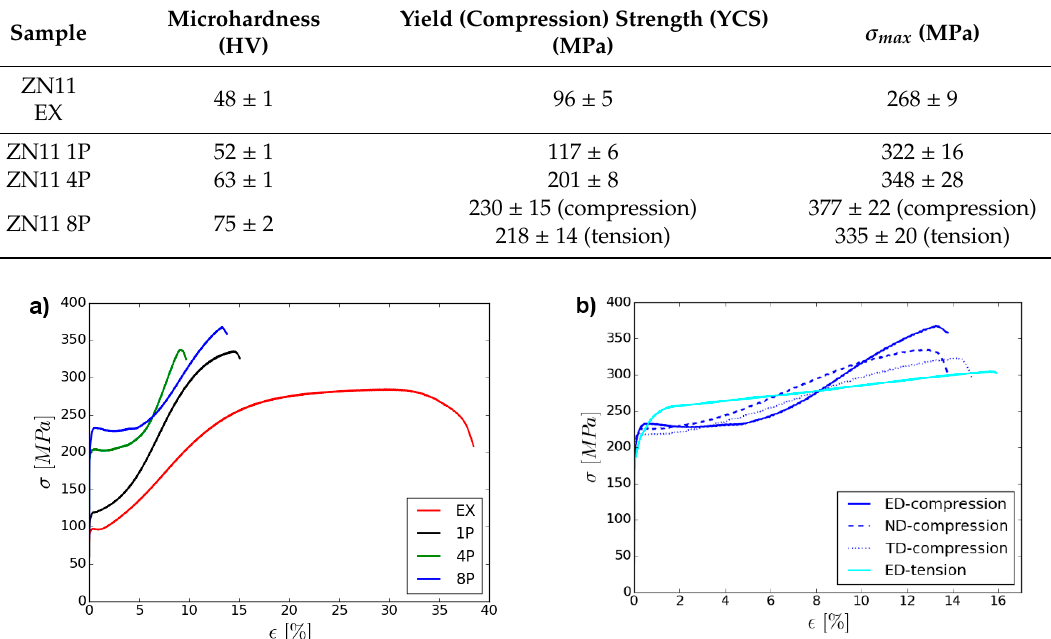
Table 2. Results of mechanical tests.